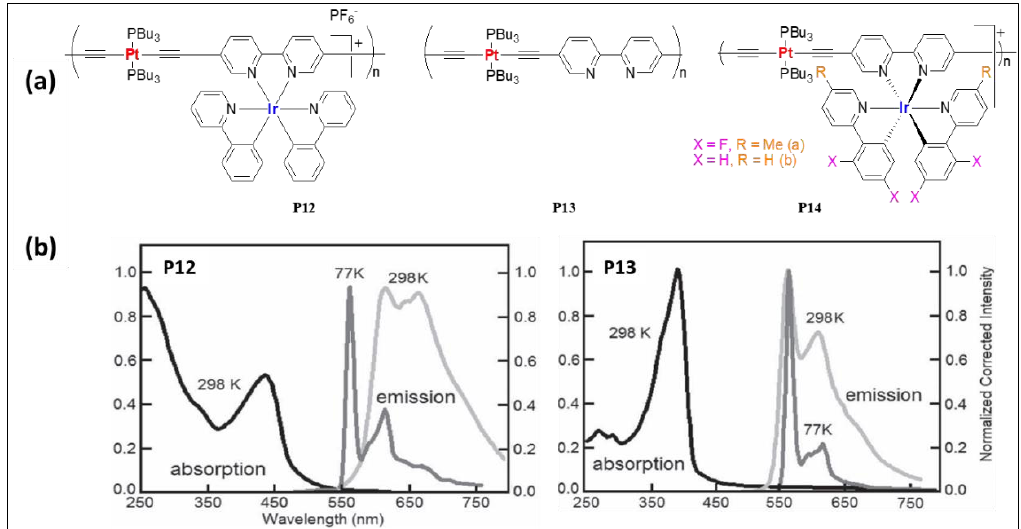
Figure 9. ( a ) Mono- and bi-metallic Pt(II)/Ir(III) polymers ( P12 – P14 ). ( b ) Absorption (298 K) and emission spectra of P12 and P13 at 298 and 77 K. Reproduced with permission from ref. [55].